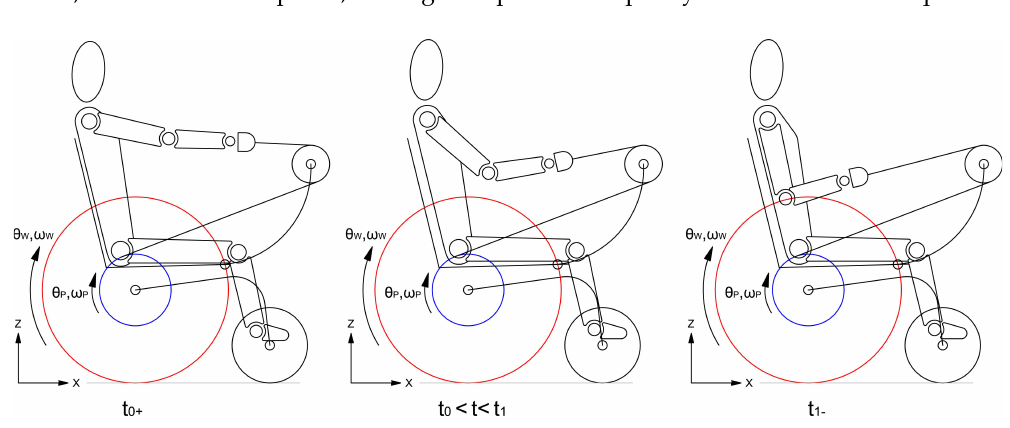
Figure 1. Rowing gesture during the traction phase.